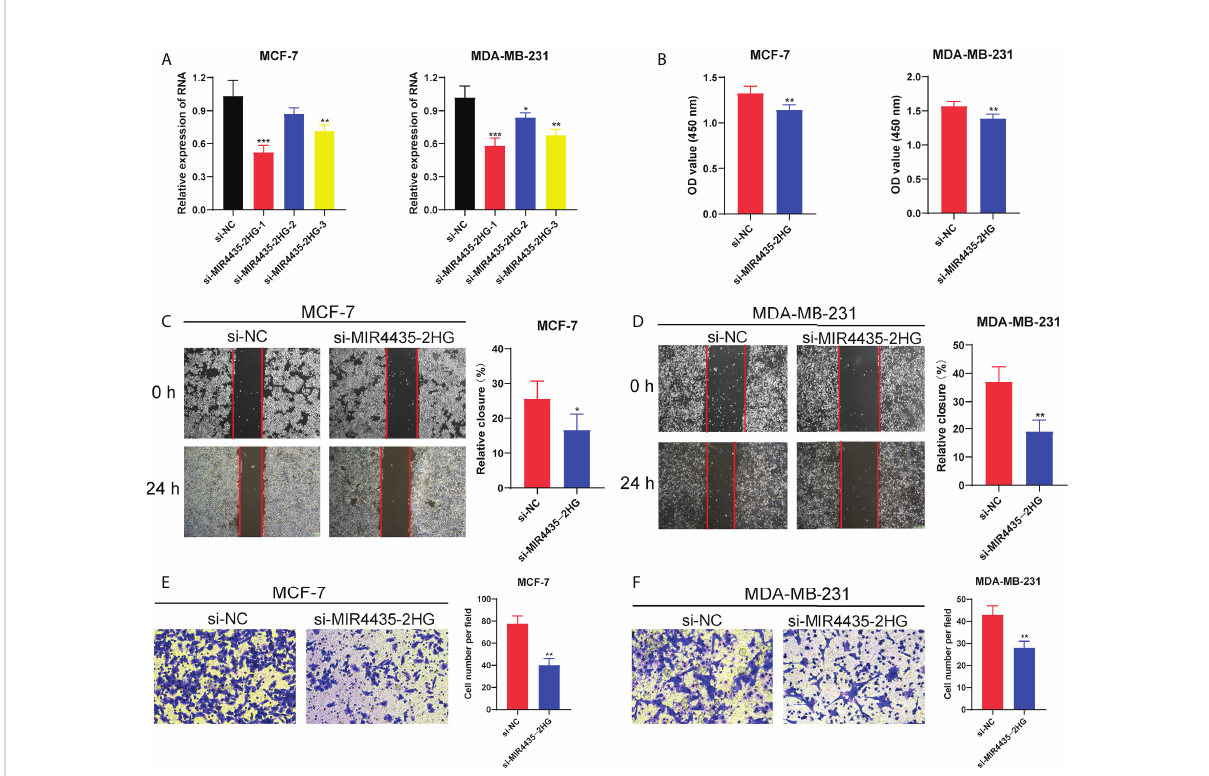
FIGURE 9 MIR4435-2HG affected BC cell proliferation and migration. (A) The RNA expression level of MIR4435-2HG in MCF-7 and MDA-MB-231 cells after silencing. (B) The CCK-8 assay showing the proliferation ability of MCF-7 and MDA-MB-231 cells after MIR4435-2HG knockdown. The scratch/wound healing and transwell assay showing the migration of MCF-7 cells (C, E) and MDA-MB-231 cells (D, F) after silencing MIR4435- 2HG. *P < 0.05; **P < 0.01; ***P <